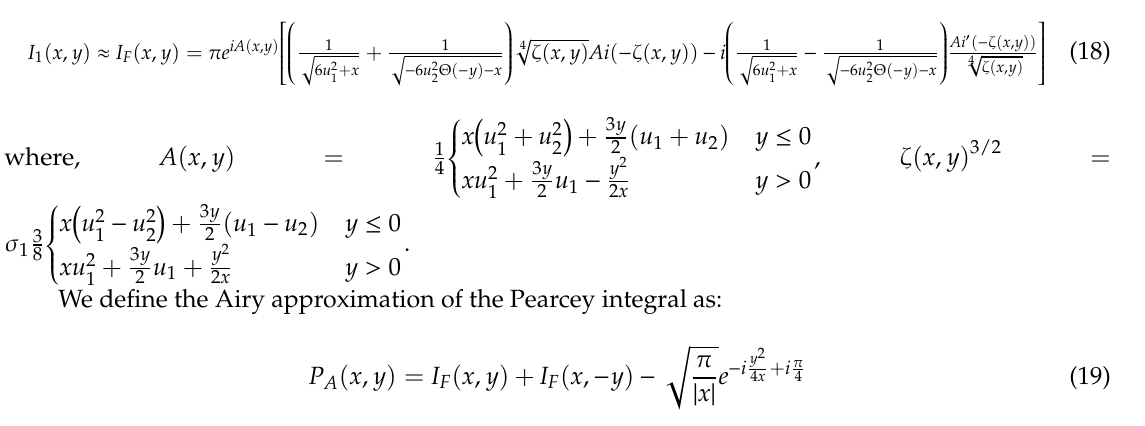
Figure 3. Saddle points ( u 1 , u 2 , and u 3 ) of the functions f ( 1 ) ( − 1, y ; u ) and f ( a) and (b ), respectively. ( a , b ),